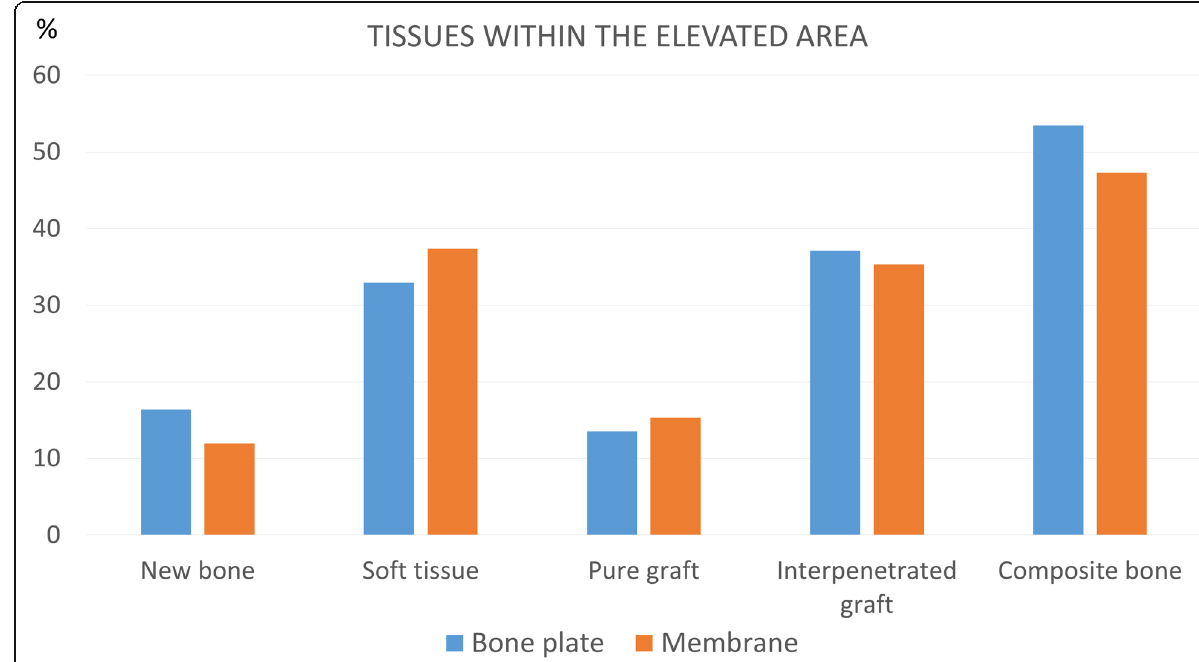
Fig. 5 Graph representing the tissue percentages within the elevated area. No statistically significant differences were found